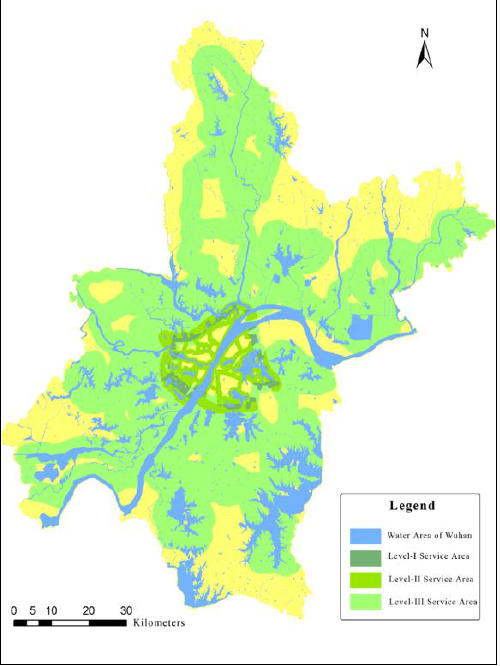
Figure 5. Spatial distribution map of the service levels of the greenway network in Wuhan.